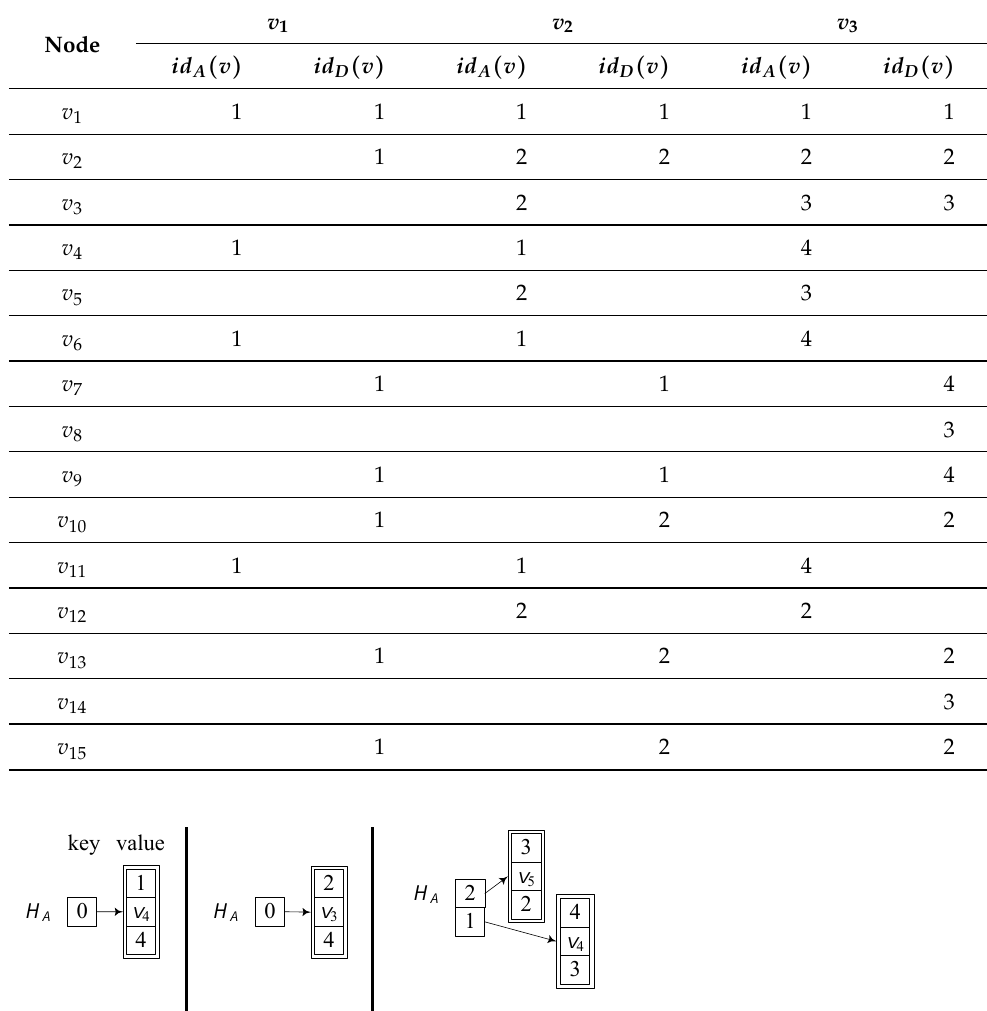
Table 2. The status of set IDs for all nodes.